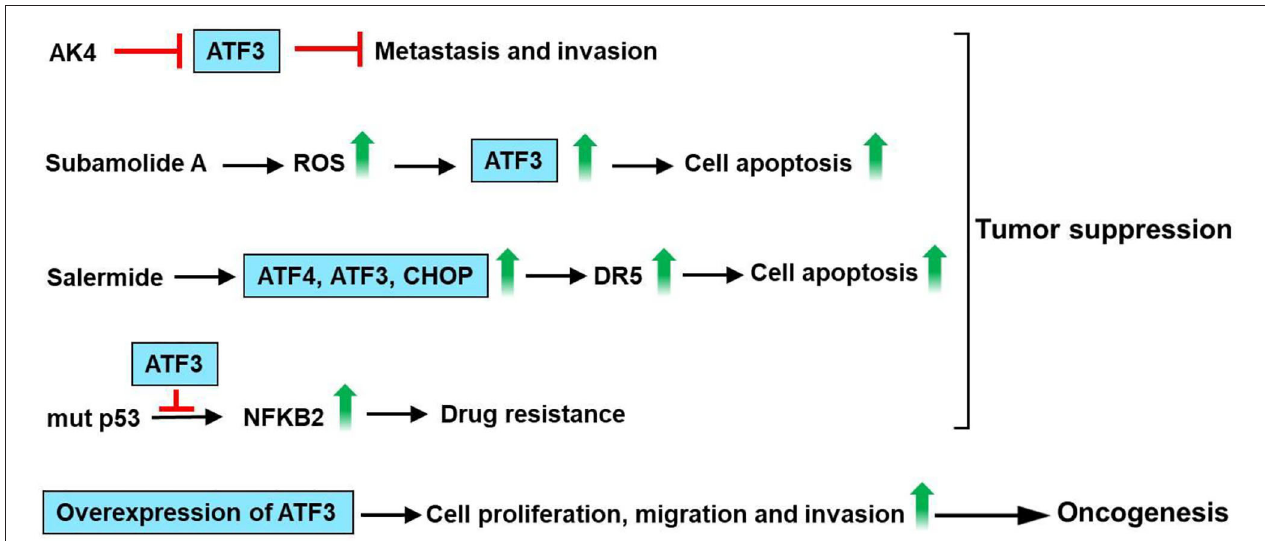
FIGURE 7 | ATF3 plays an important role in lung cancer. ATF3 was identified as a vital regulatory target of adenylate kinase-4 (AK4). AK4 stimulates metastasis of lung cancer by downregulation of ATF3 expression. Subamolide A induced mitotic catastrophe and apoptosis, mainly via ROS upregulation that induces ataxia-telangiectasia mutation (ATM) and ATF3 activation, subsequently resulting in p53-mediated cell death. In addition, salermide upregulates ATF3 expression and triggers ER stress in human non-small cell lung cancer (NSCLC) cells, which regulates the induction of the ATF4-ATF3-C/EBP homologous protein (CHOP) axis that results in DR5-dependent apoptosis. ATF3 decreases nuclear factor kappa B subunit 2 (NFKB2) expression and reverse drug resistance caused by mutant p53 protein in H1299 cells. These findings suggest that ATF3 acts as a tumor suppressor for lung cancer. However, knockdown of ATF3 expression by RNA interference significantly inhibited the cell proliferation, migration, and invasion in A549 and H1299 cells. These observations show that ATF3 acts as an important regulator in lung cancer.